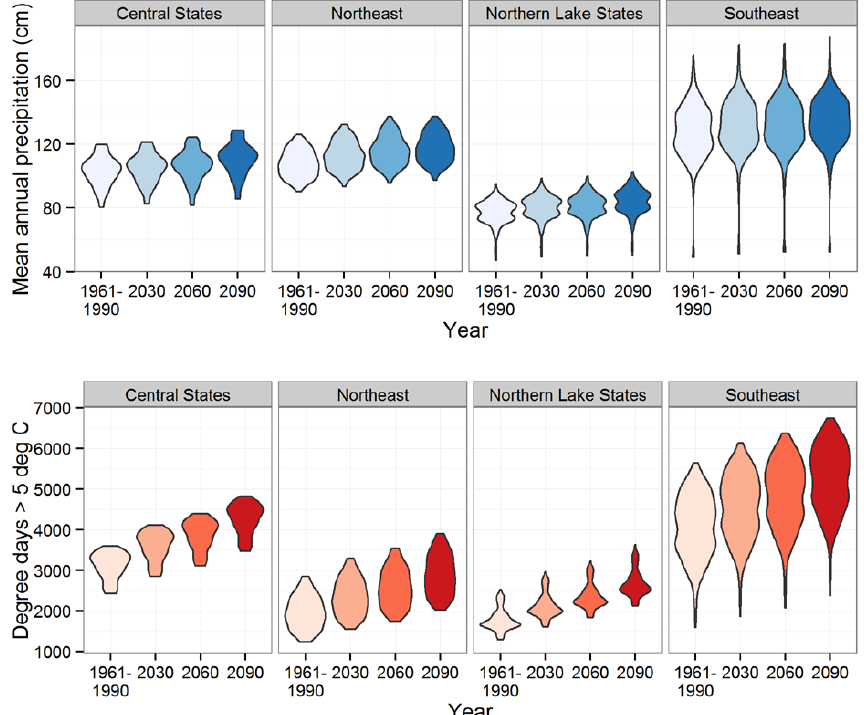
Figure 1. Violin plots of precipitation and degree day trends for study plots by geographic region across the eastern US for the climate normal period (1961–1990) and projected climates using an ensemble of 17 GCMs for CMIP5 models and an RCP 6.0 scenario.